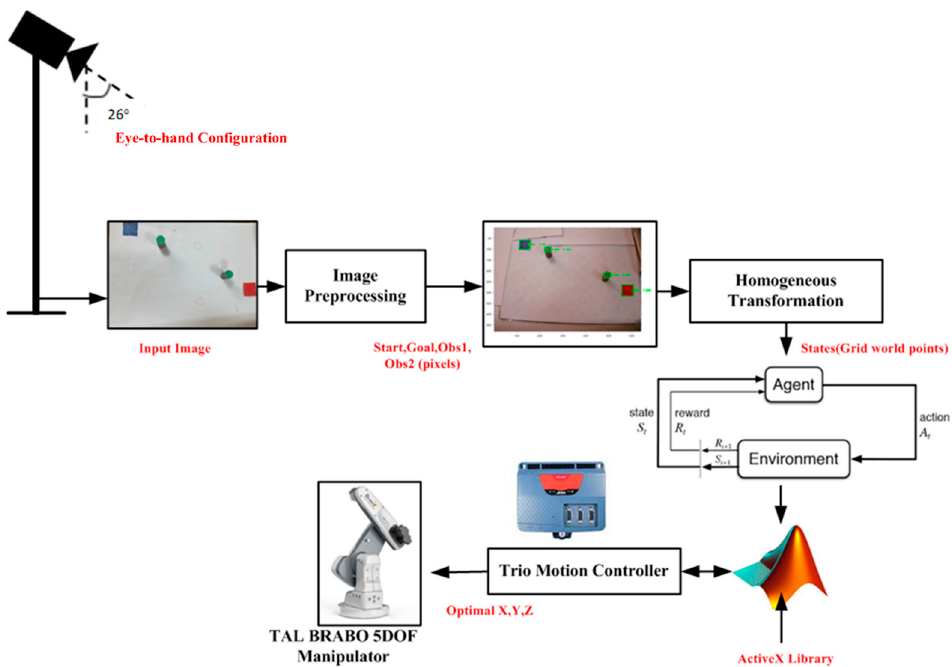
Figure 4. Process Flow of Vision-Based Obstacle Avoidance using Different Reinforcement Learning Algorithms.